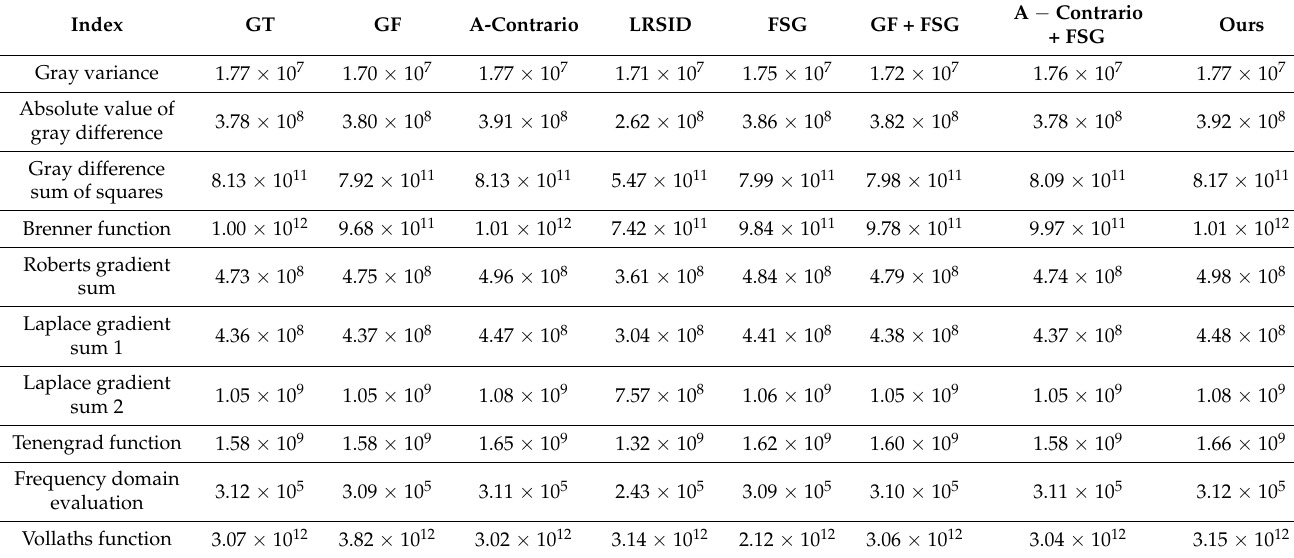
Table 2. Contrast of sharpness index of simulation image after striping removal.